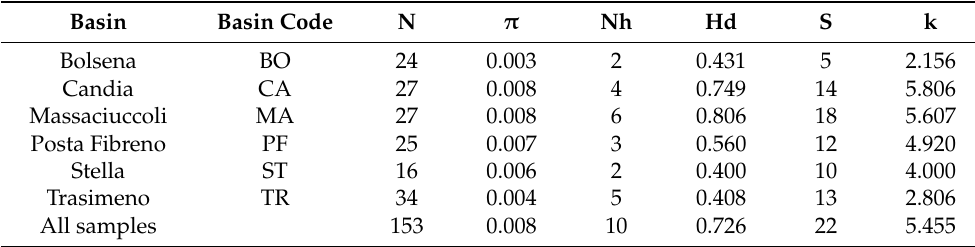
Table 1. Estimates of mtDNA control-region genetic diversity indexes for all basins here analyzed (N = number of samples; π = nucleotide diversity; Nh = number of haplotypes; Hd = haplotype diversity; S = number of polymorphic sites; k = Tajima’s average number of nucleotide